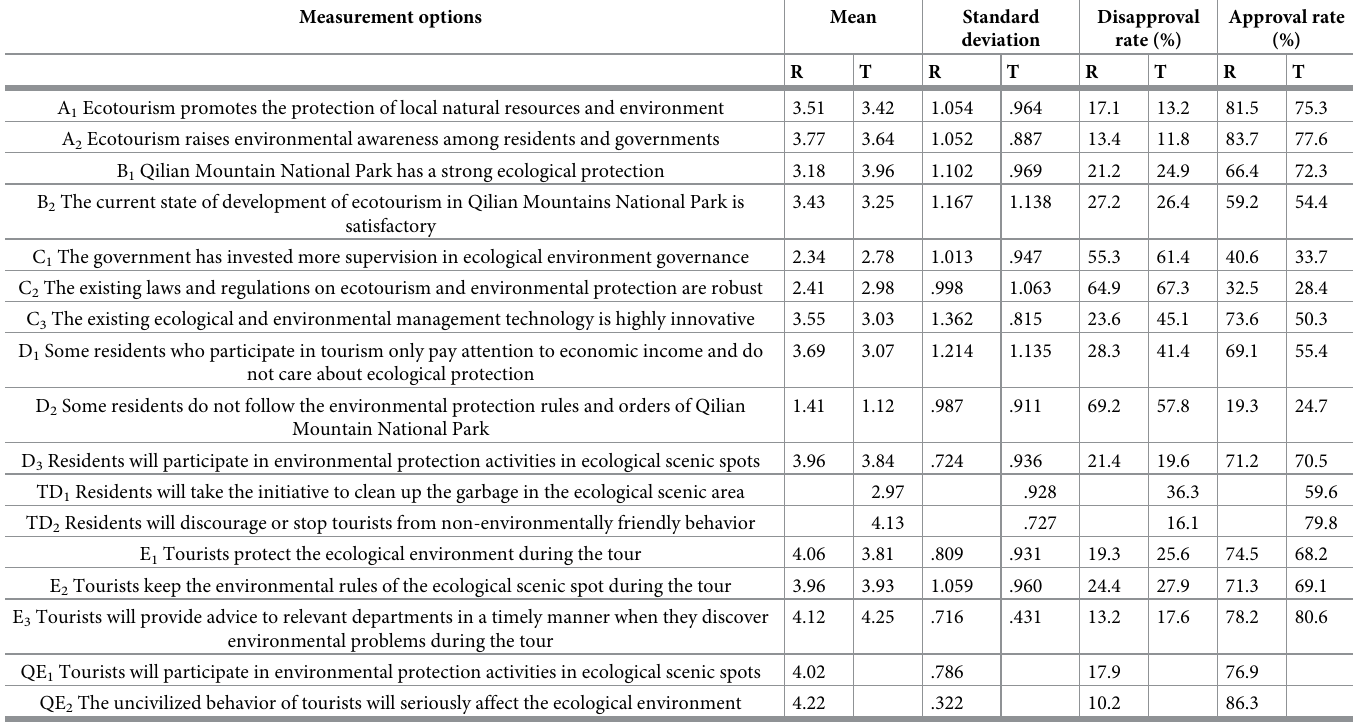
Table 18. A comparative analysis of the ecotourism environmental responsibility perception perceived by residents and